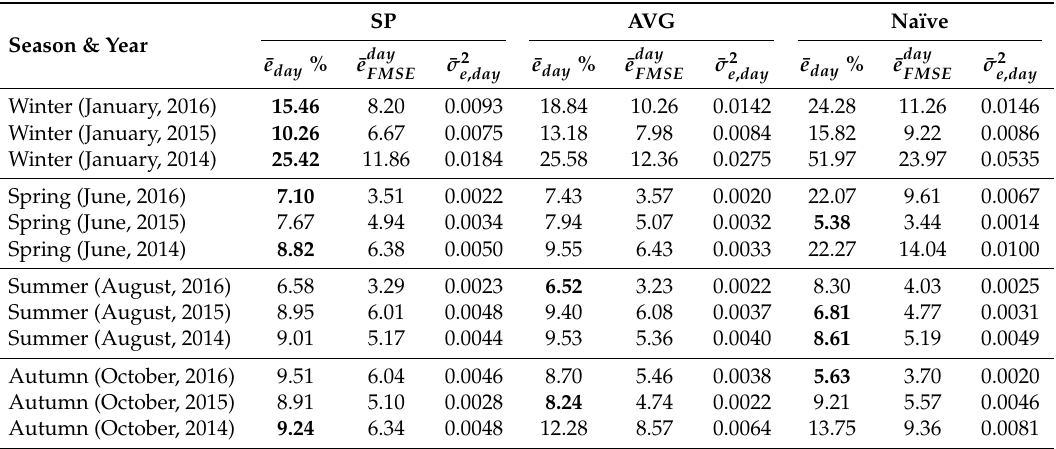
Table 11. Average values of ¯ e day (%), ¯ e day to evaluate the SP model, average and naïve